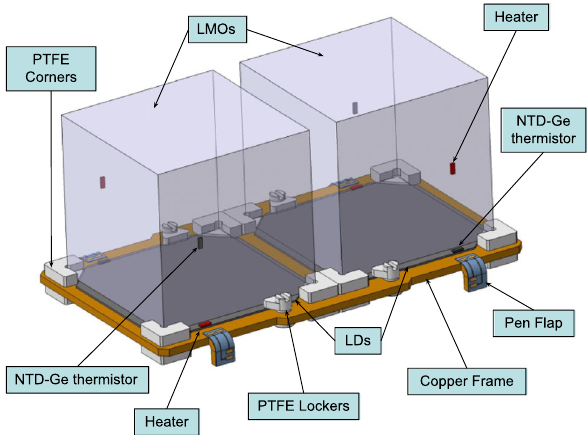
Fig. 1 Rendering of a single CUPID module which consists of 2 cubic LMO crystals and 2 LDs spaced 0.5mm from the bottom faces. The detectors are held by the copper frame and PTFE elements. A tower is built by simply stacking one module on top of the other. The detector components are labeled in the